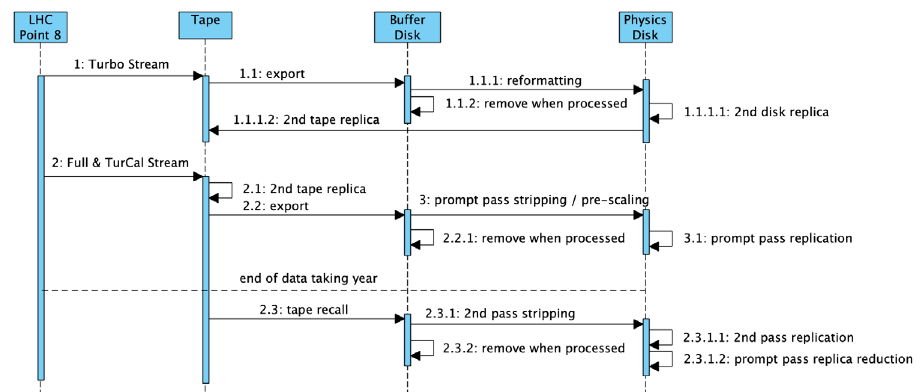
Figure 1. Logical workflow of the o ffl ine data processing in Run